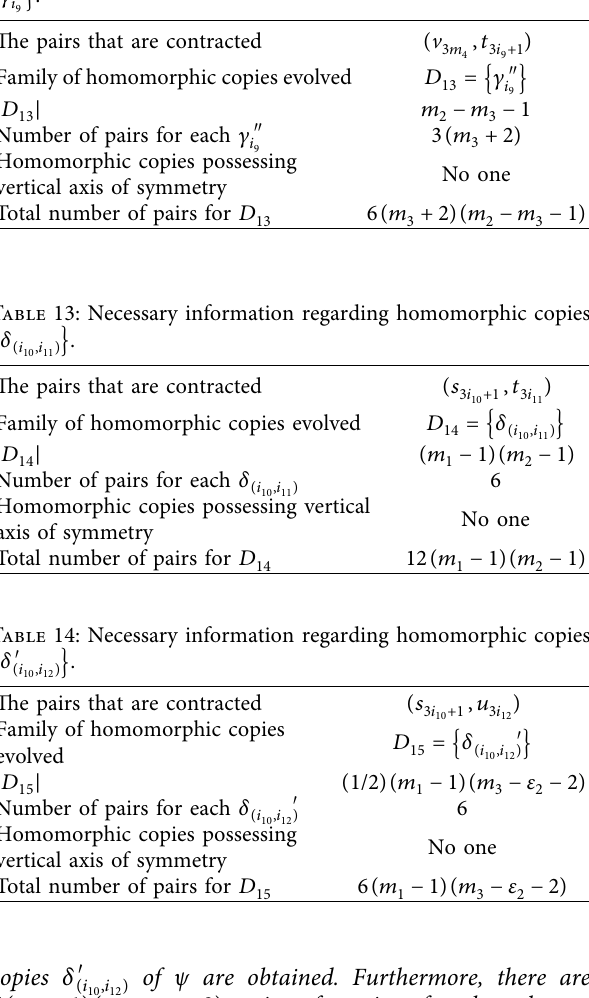
Table 12: Necessary information regarding homomorphic copies c ″ 􏽮 i 9